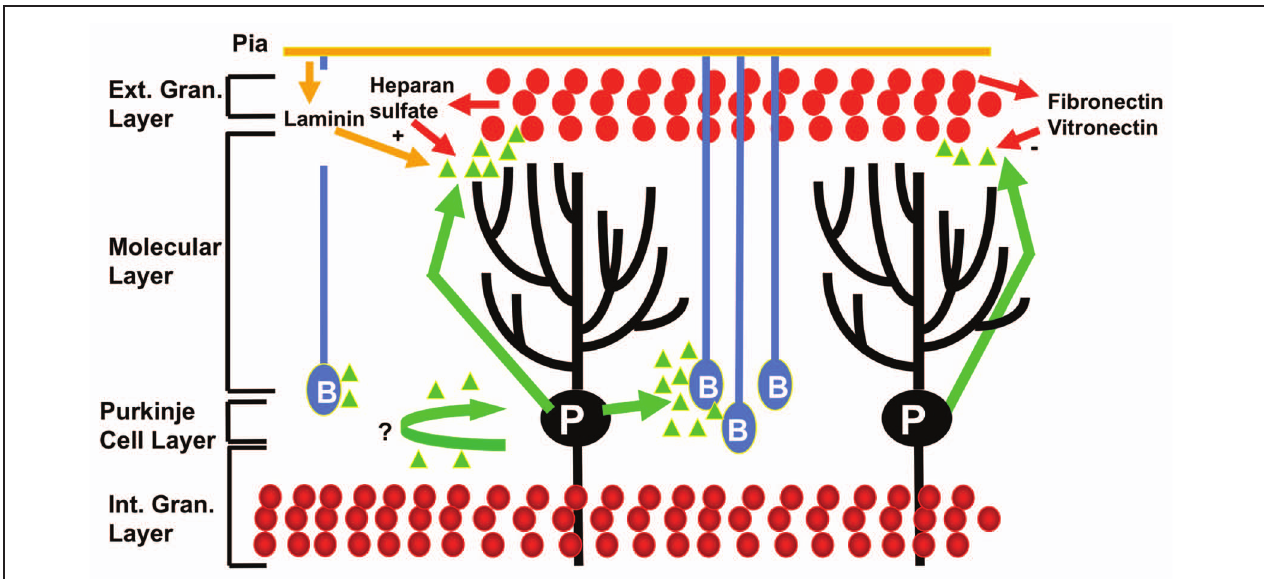
maturation. The promitogenic effect on cerebellar granular neuronal precursor cells is synergized by cooperative modulators such as laminin and heparin sulfate, whereas fibronectin and fibronectin act as negative modulators. Mature granular cells are represented at the level of the internal granular layer (bottom part of the figure). Adapted from Vaillant and Monard